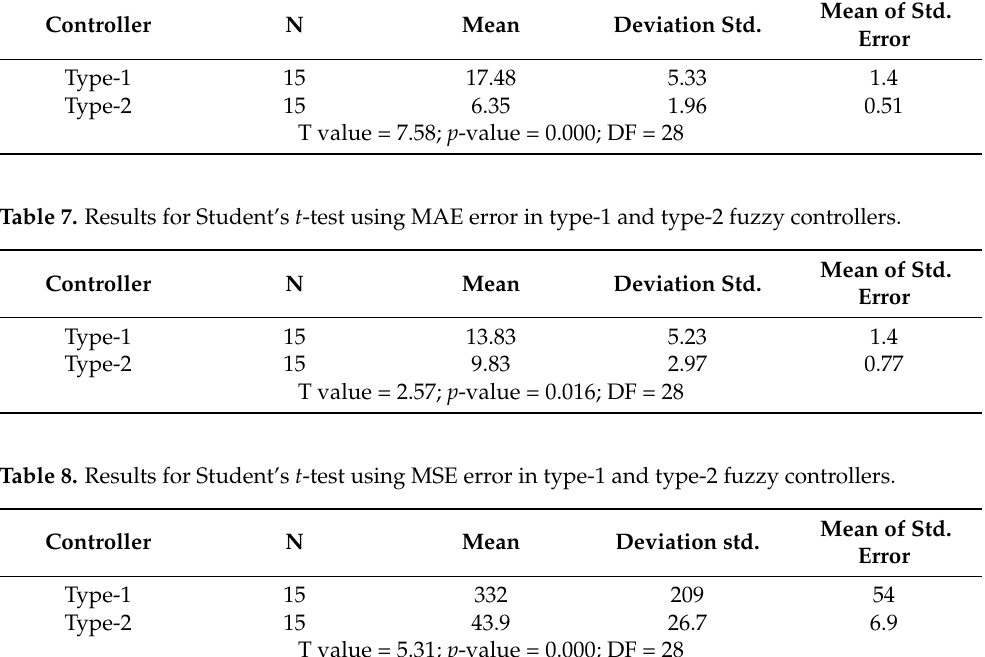
Mean of Std. Error